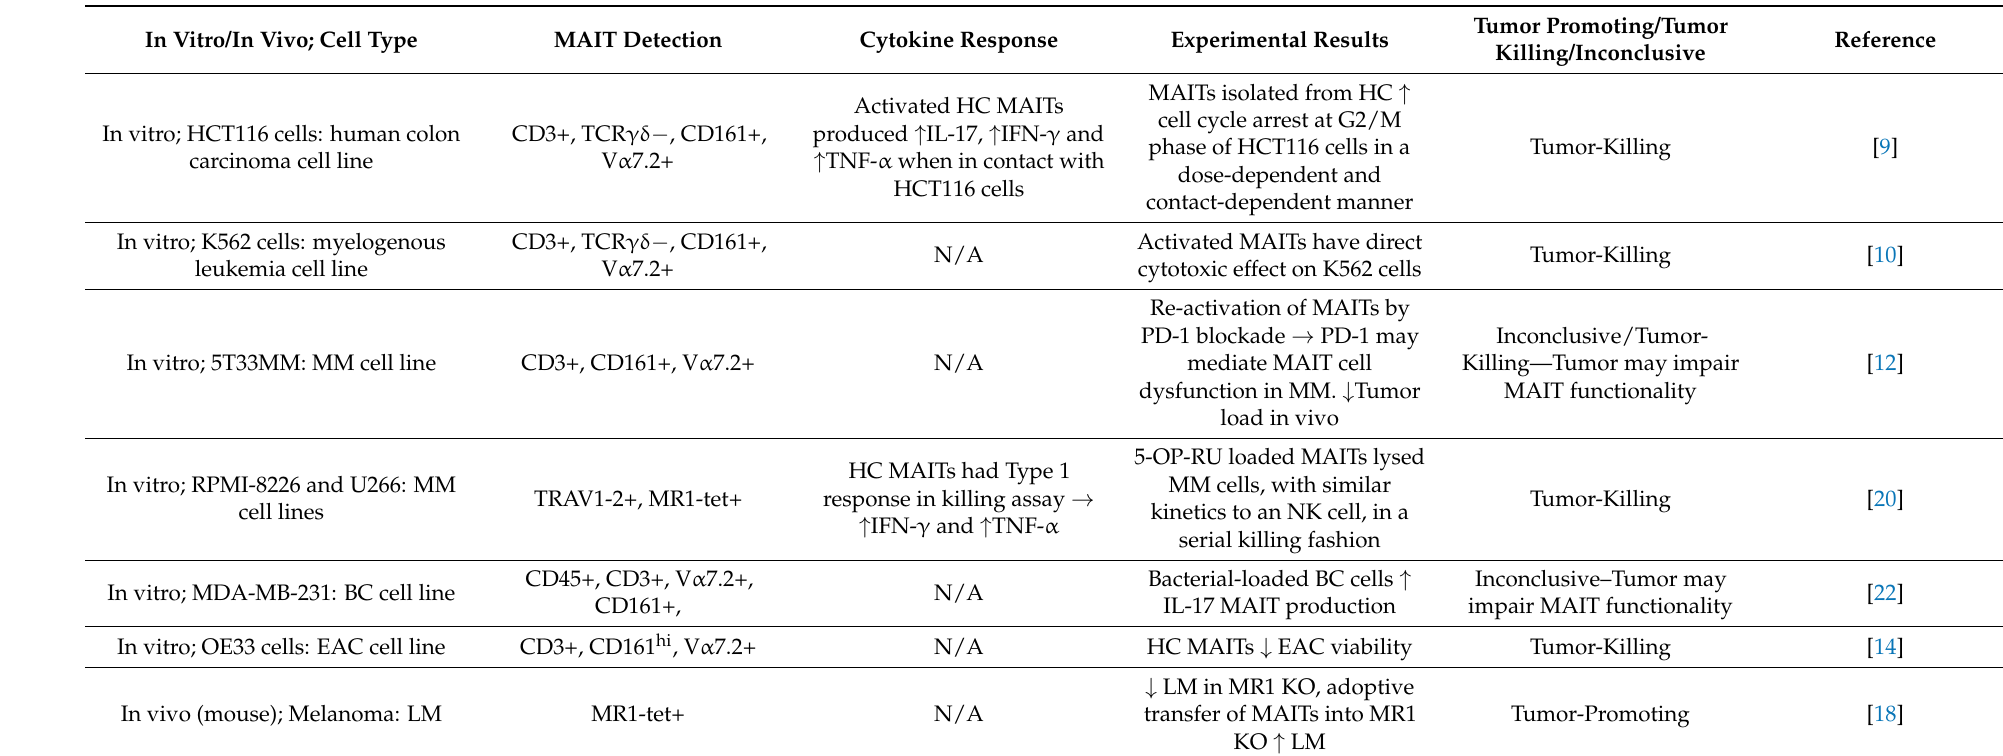
Table 2. In vivo and in vitro